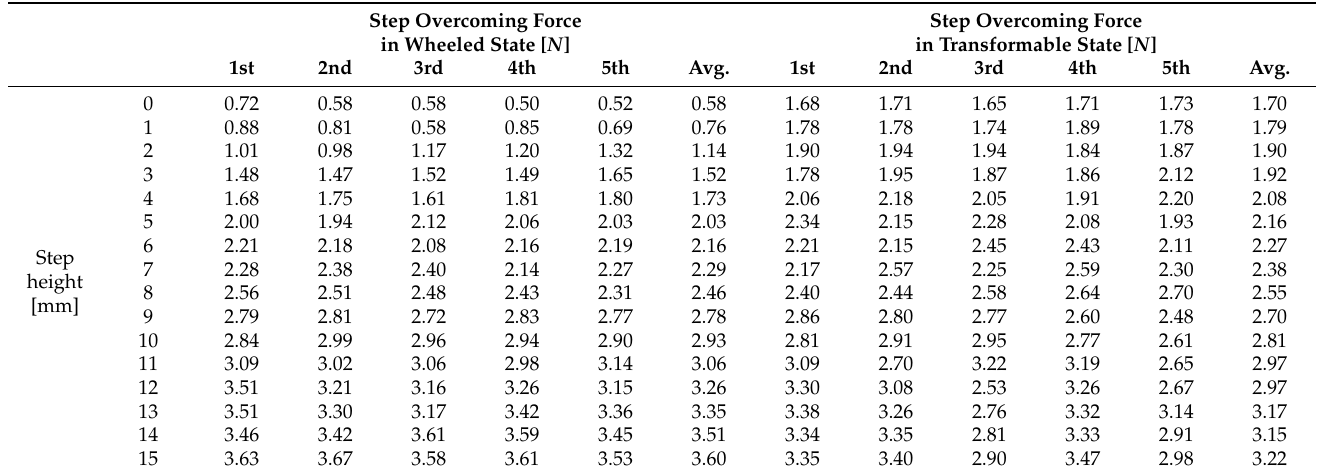
Table 3. Step overcoming force of the wheel state according to the height of the step.